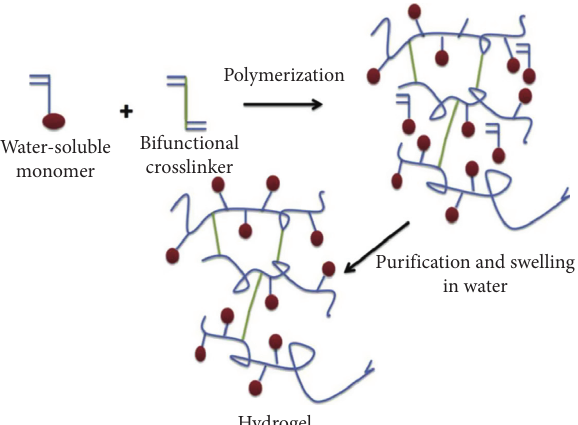
Figure 3: Schematic representation of the synthesis of hydrogels by three-dimensional